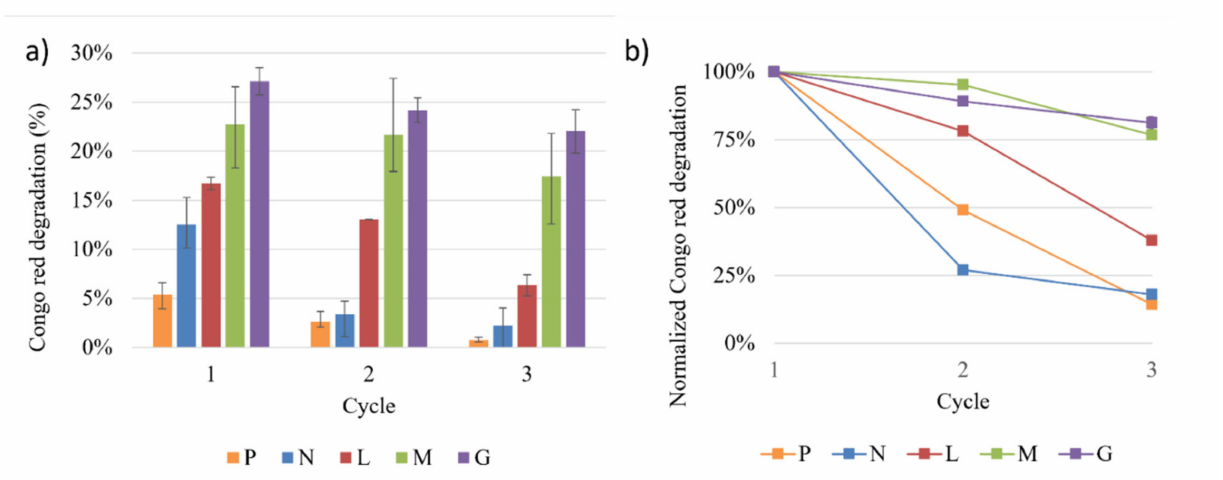
Figure 8. Decolorization measurements of Congo Red using the different filters: filter paper (P), P filter with magnetite nanoparticles (N), P filter with Lac-case-magnetite (L), P filter with Laccase- magnetite with magnets (M), P filter and Laccase-magnetite with magnets and a metal mesh (G). ( a ) decolorization per cycle, ( b ) normalized decolorization per